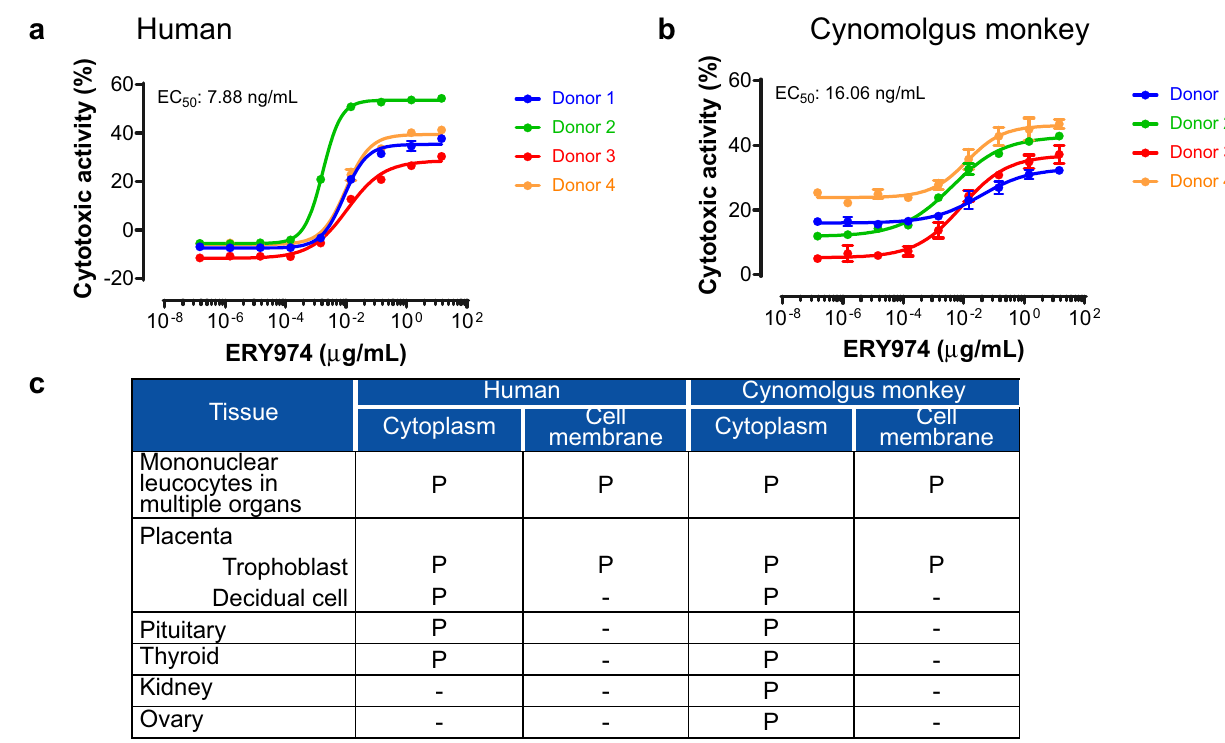
Figure 4. Cynomolgus monkey is a suitable species to study the safety of ERY974. ( a ) Cytotoxicity assay for ERY974 using human PBMCs. ( b ) Cytotoxicity assay for ERY974 using cynomolgus monkey PBMCs. PBMCs from four independent donors are used as effector cells, and SK-pca13a was used as the target cell. Data are shown as mean ± SD (n = 3). ( c ) Summary of tissue cross-reactivity of ERY974 in human and cynomolgus monkeys. Frozen sections of various normal tissues from human and cynomolgus monkeys were stained with biotinylated ERY974. Tissues positive for ERY974 staining are shown with “P,” and tissues negative for ERY974 staining are shown with “-.” Cyno means cynomolugus monkey.